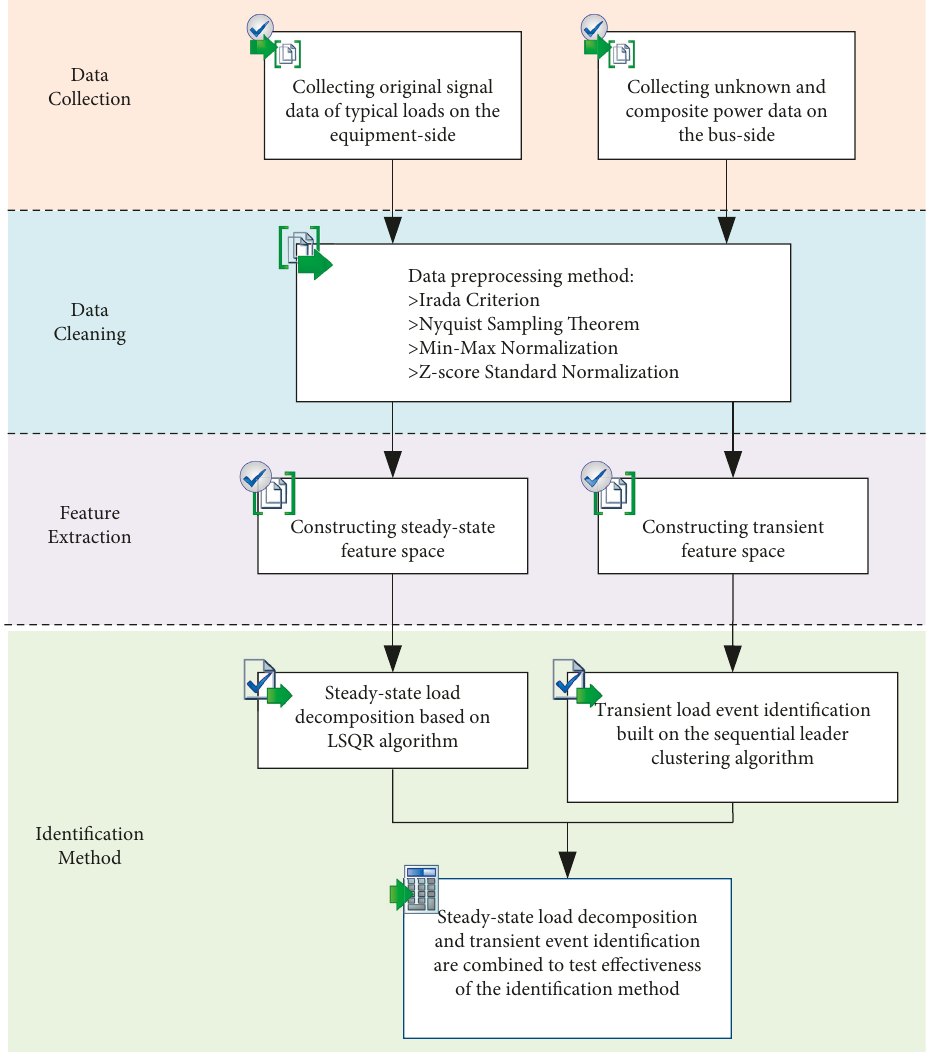
Figure 2: Flow chart of the proposed load identification